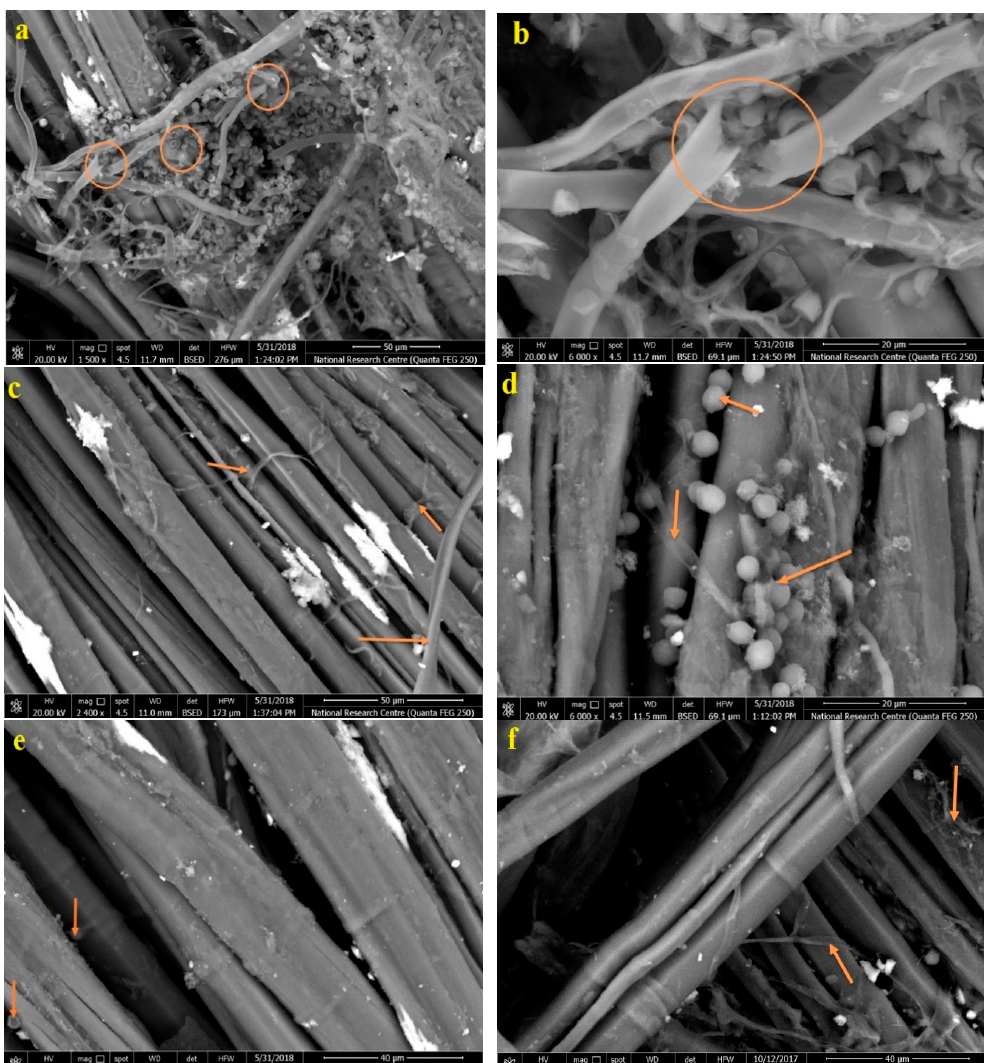
Figure 6. SEM images of the linen fibres treated with the oil and colonized with the fungi; ( a , b ) linen treated with oil and incubated with A. flavus; ( c , d ) linen treated with oil and incubated with C. cladosporioides; ( e , f ) linen treated with oil and incubated with P. chrysogenum . Arrows and circles refer to the growth and damage found in the fungal structures.